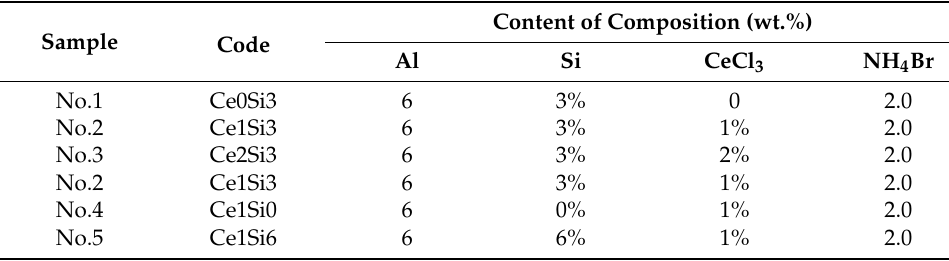
Table 2. Composition of pack mixture for applying aluminide coatings *.